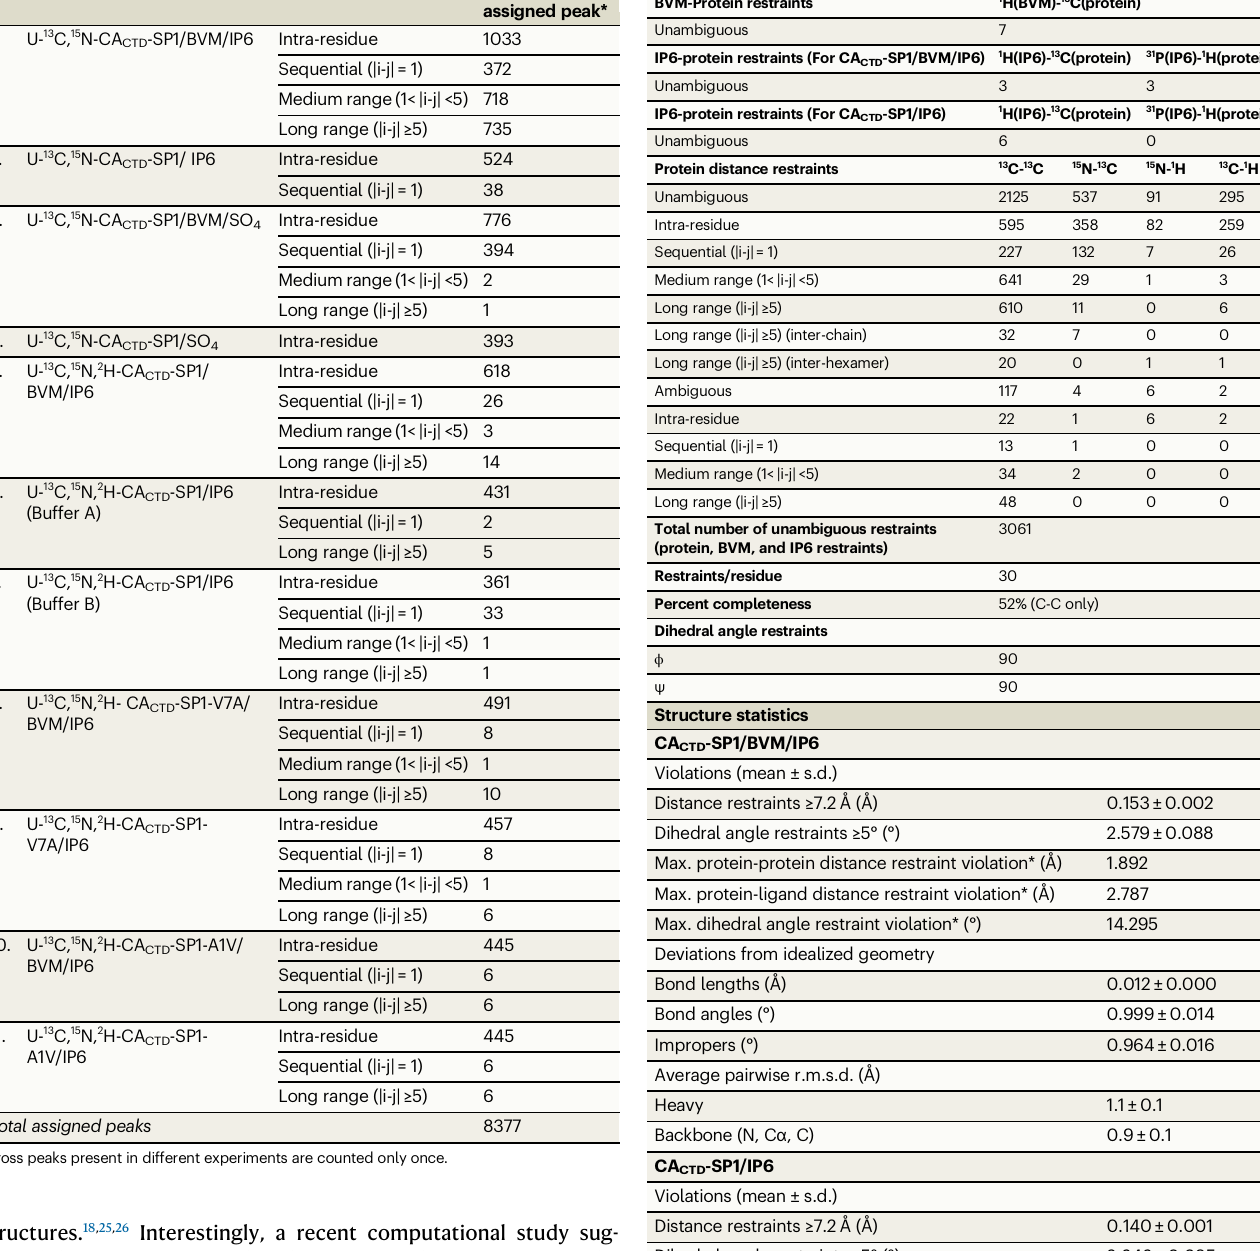
Table 1 | Summary of samples and the number of assigned peaks ID